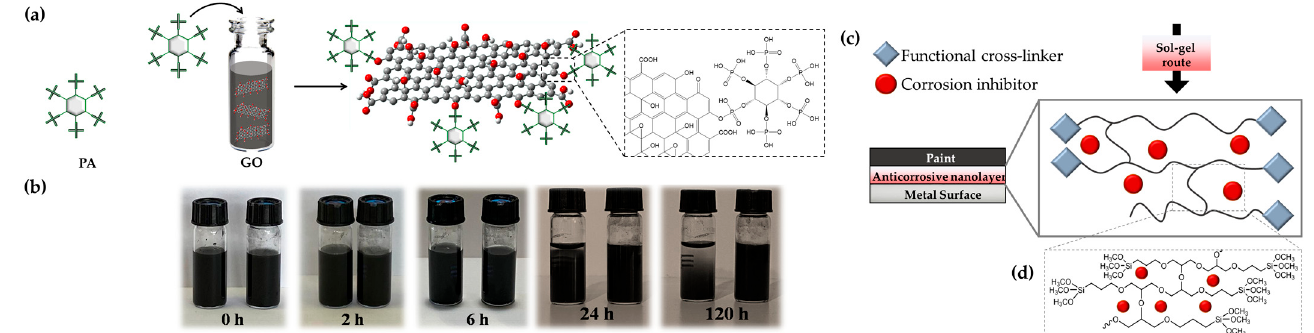
Figure 4. Graphene oxide intercalated phytic acid interaction ( a ) and stability of the obtained water dispersions ( b ). Sol–gel-based approach with proper silane precursors for the production of sustainable waterborne anticorrosive protective coatings ( c ) and cross-linked matrix ( d ). Reproduced from MDPI Ref. [57].